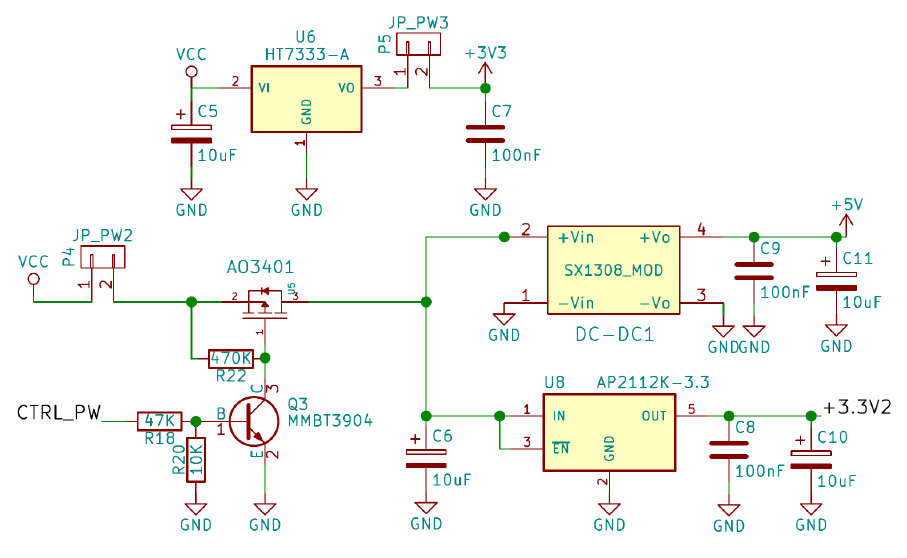
Figure 9. Schematic corresponding to the control and adjustment circuit of the power